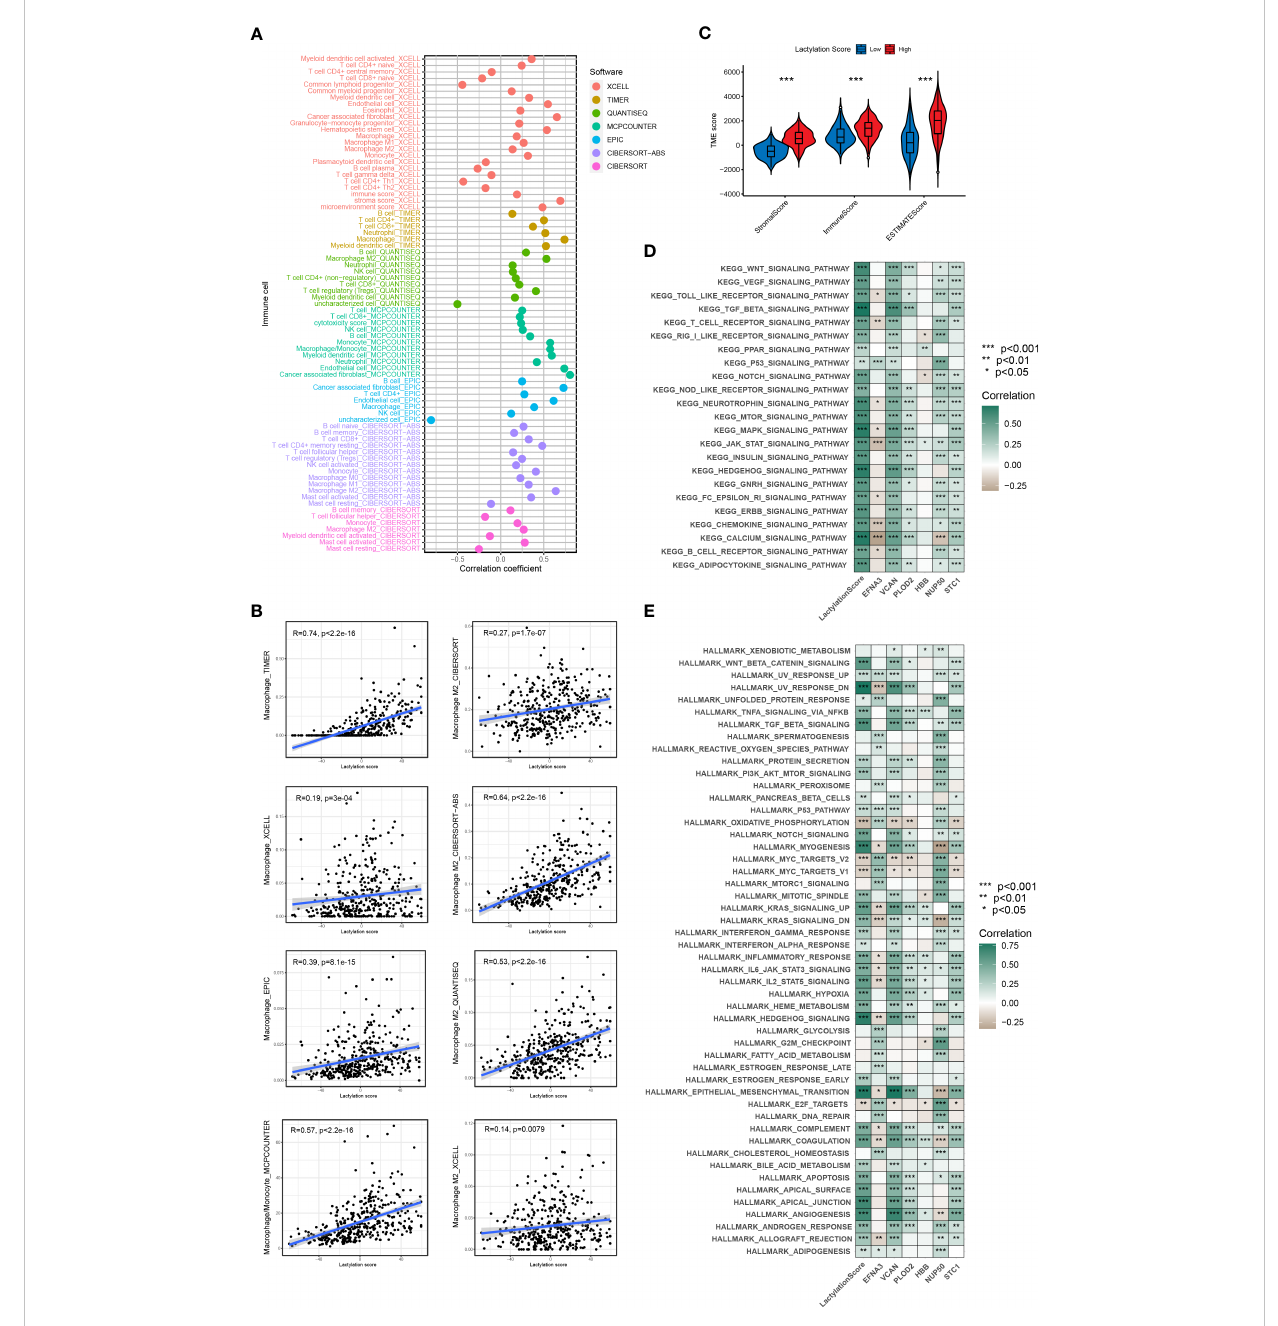
FIGURE 5 Immune cells in fi ltration and function enrichment analysis. *p<0.05; **p<0.01; ***p<0.001. (A, B) The correlation between lactylation score and immune cell in fi ltration by various immunocytes analysis methods. (C) Correlation between lactylation score and the tumor microenvironment of gastric cancer assessed using the ESTIMATE algorithm. (D, E) GSVA analysis of lactylation score and lactylation-related